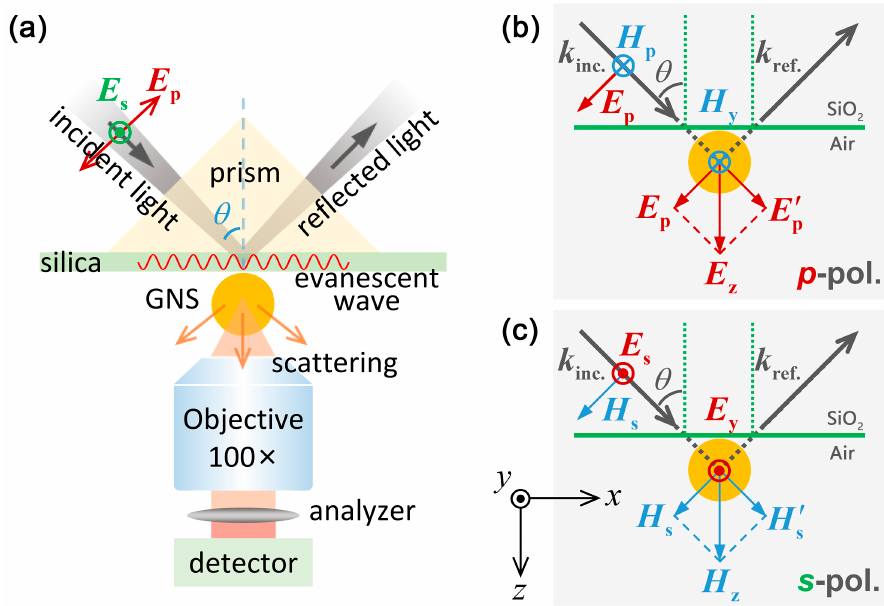
Figure 2. ( a ) Schematic showing the excitation of a GNS with the evanescent wave generated in a total internal reflection configuration and the detection of the quadrupole radiation of the GNS by filtering out the dipole radiation with a cross-polarized analyzer. The incidence angle is chosen to be θ ~ 45 ° . ( b ) Schematic showing the excitation of a GNS by using the evanescent wave generated with p -polarized light. ( c ) Schematic showing the excitation of a GNS by using the evanescent wave generated with s -polarized light. In ( b ) and ( c ), the combined electric and magnetic fields of the incident and reflected light which determine the orientations of the ED and magnetic dipole (MD) induced in the GNS by p - and s -polarized light are illustrated.